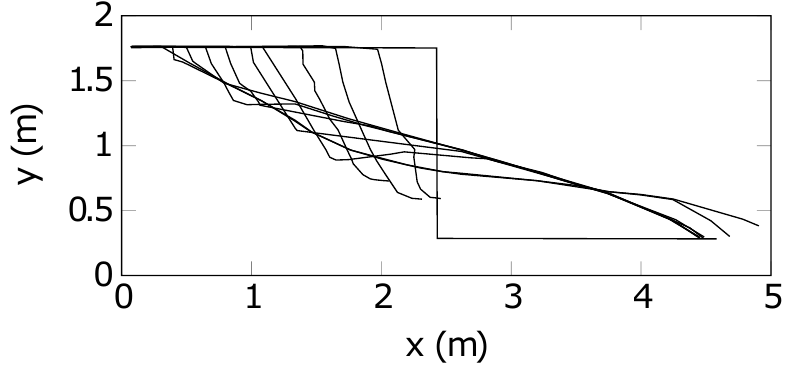
Figure 7. Deposit profiles plotted every 90 s for Experiment 8. Linear interpolation was used for obscured parts by the vertical steel